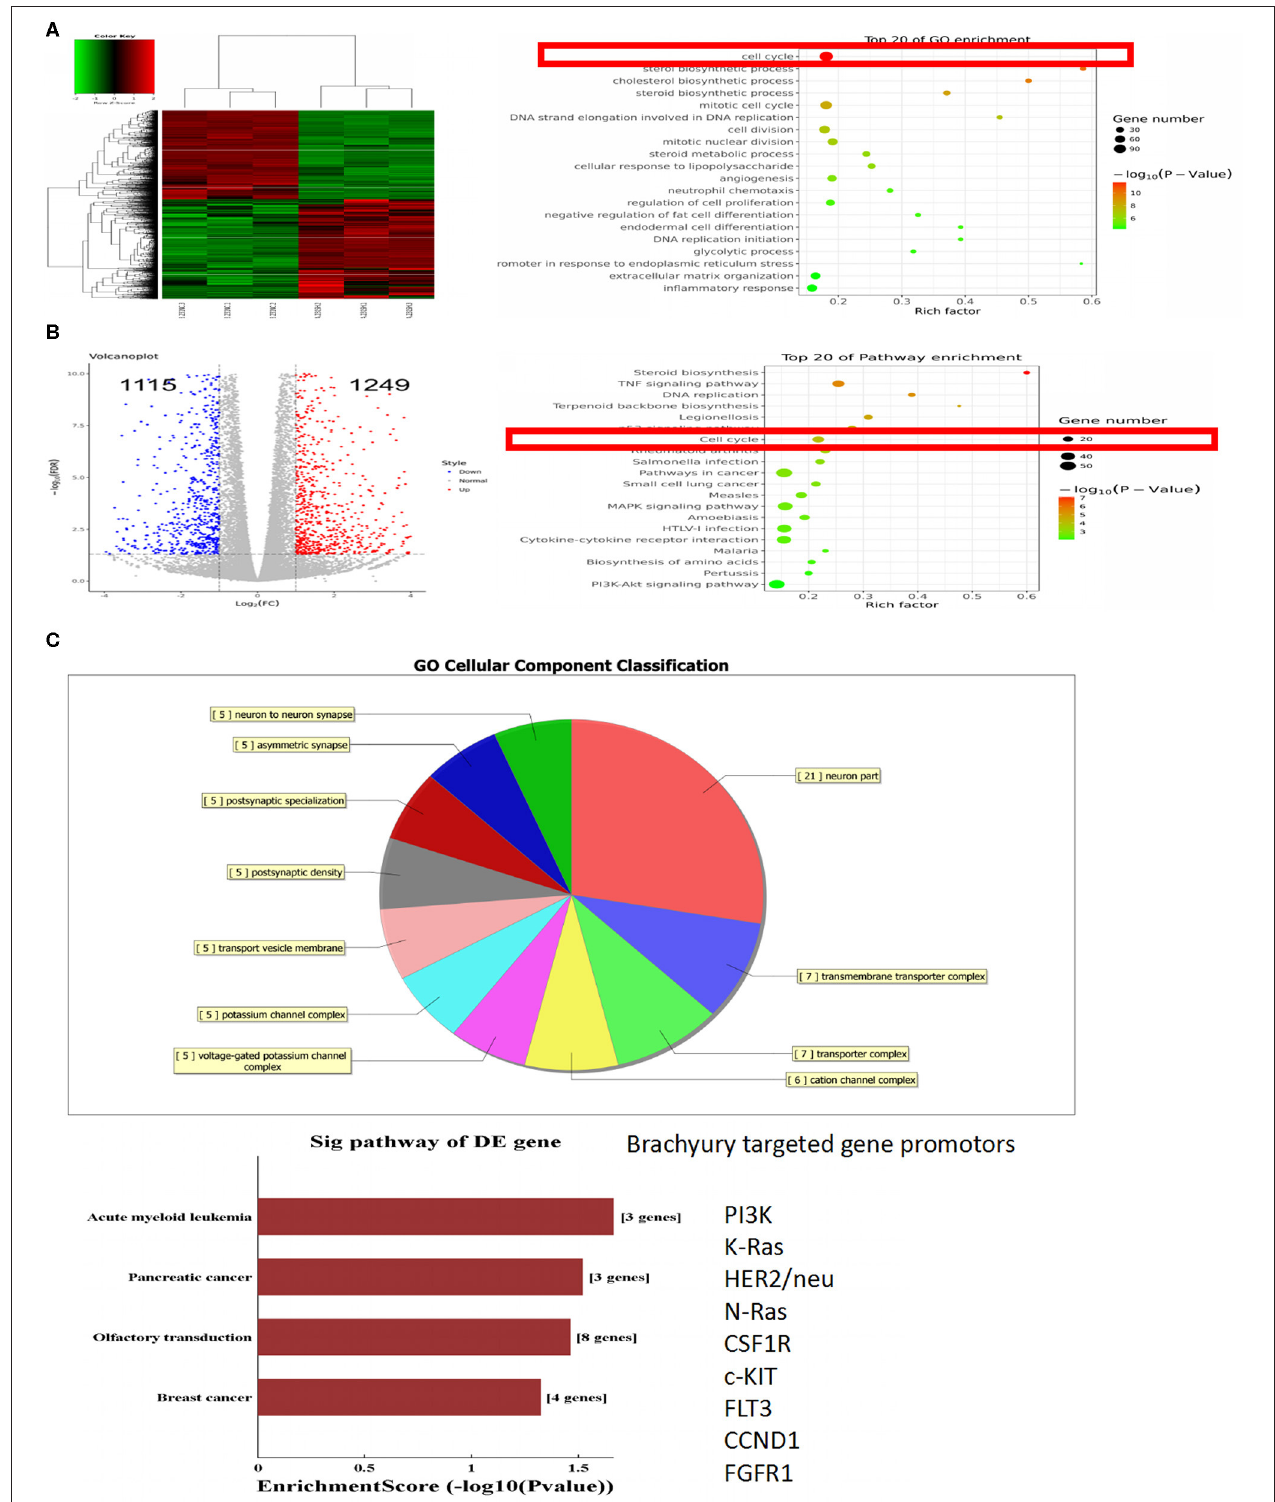
FIGURE 1 | RNA-sequence and ChIP-sequence analyses of MDA-MB-231 cells. (A) Heat map of differentially expressed transcripts, Gene ontology (GO) analysis, and (B) pathway analysis, based on all identified transcripts. (C) Cellular component classification analysis and targeted genes of ChIP-seq. P -value of GO analysis and enrichment of pathway analysis are listed for each category. P -value of pathway is colored in red ( P < 0.05).